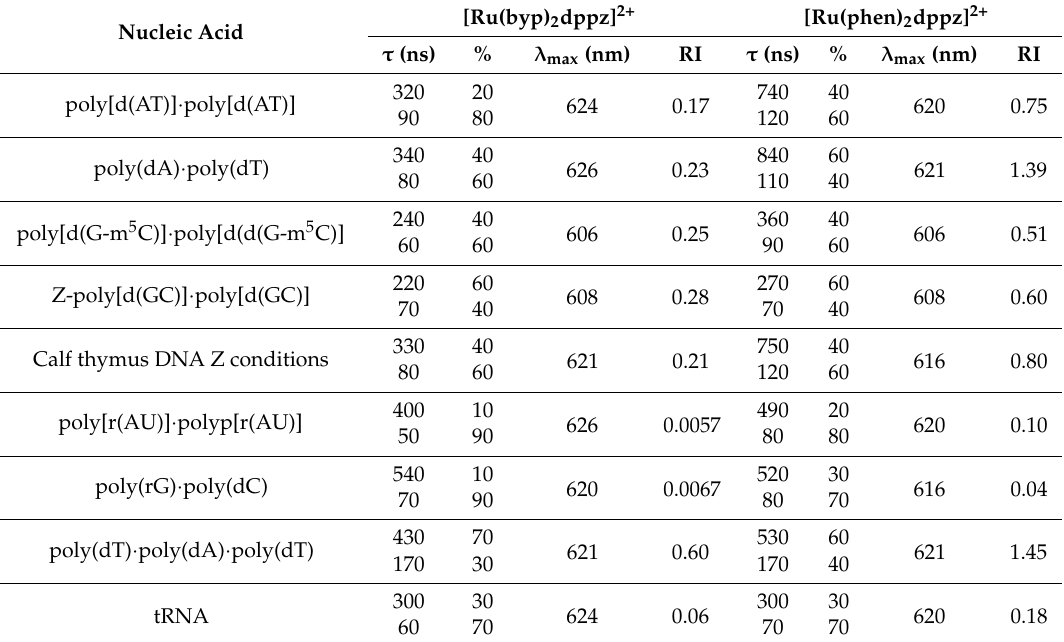
Table 2. Binding constant (K), binding site size (n), lengthening upon single intercalation (x eq ) and twist between successive base pairs upon intercalation obtained from various force spectroscopy experiments (atomic force microscopy (or scanning force microscopy), magnetic tweezers, optical tweezers). Reproduced with permission from the authors of [43]. Copyright © 2016, Oxford University Press.